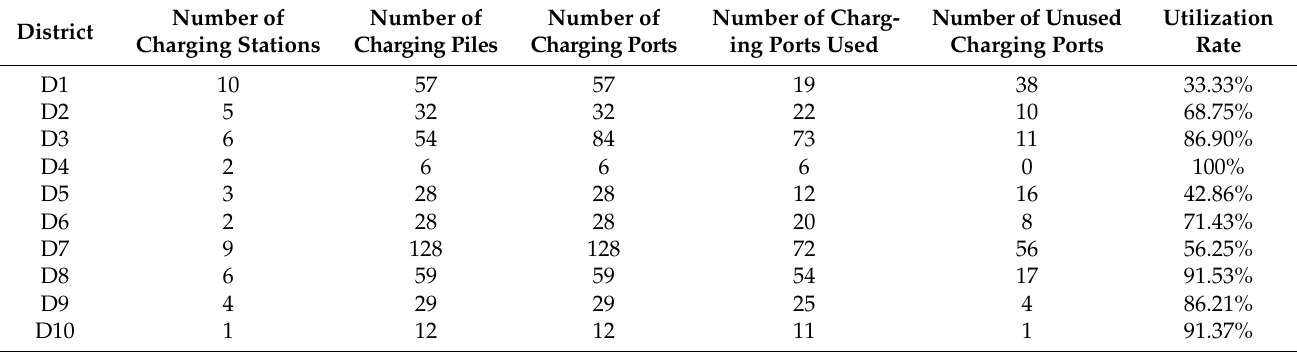
Table 2. Charging facilities by district in City S.